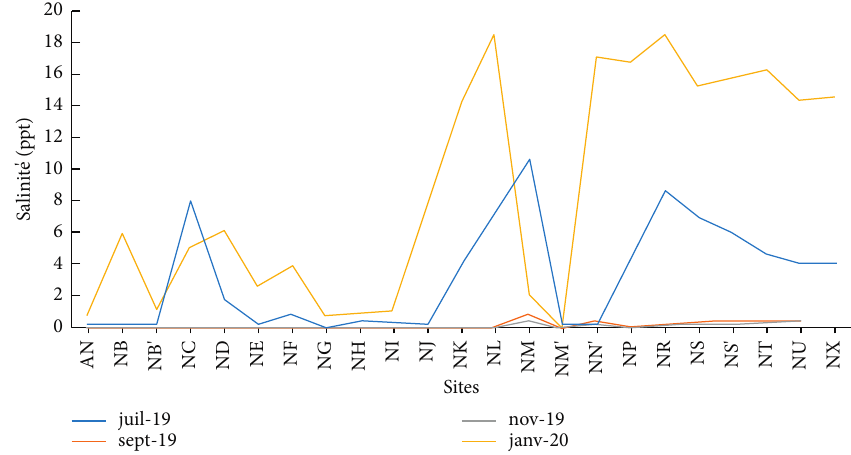
Figure 5: Temporal variation of the salinity in the water of Lake